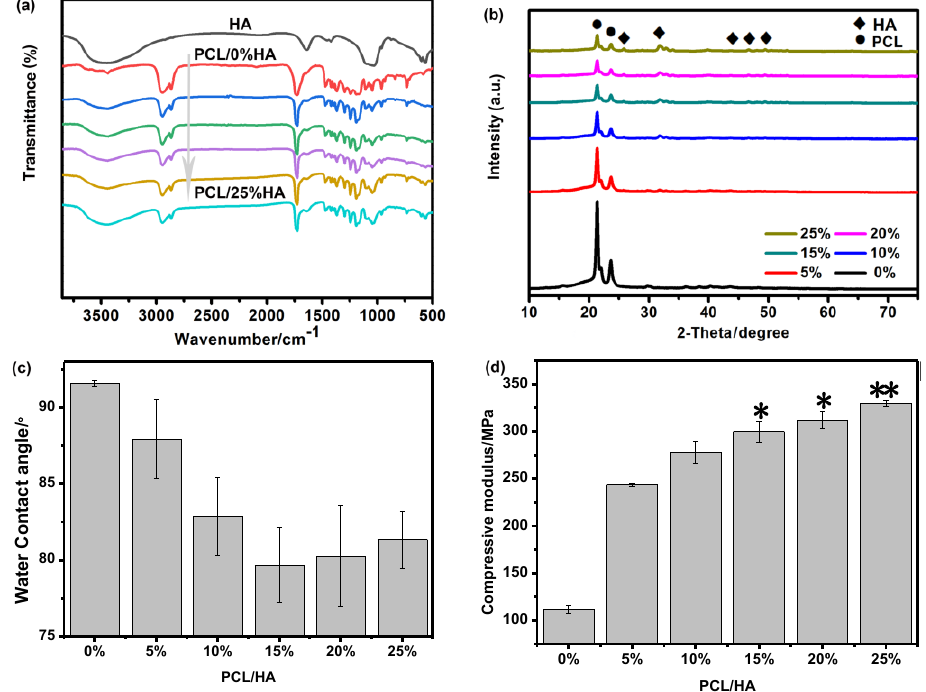
Figure 2. Characterization of different PCL/HA scaffolds with different content of HA, ranging from 0% to 25%. ( a ) FT-IR result; ( b ) XRD spectra; ( c ) Water contact angle; and ( d ) Compressive modulus,* p < 0.05, ** p < 0.01, vs. PCL.